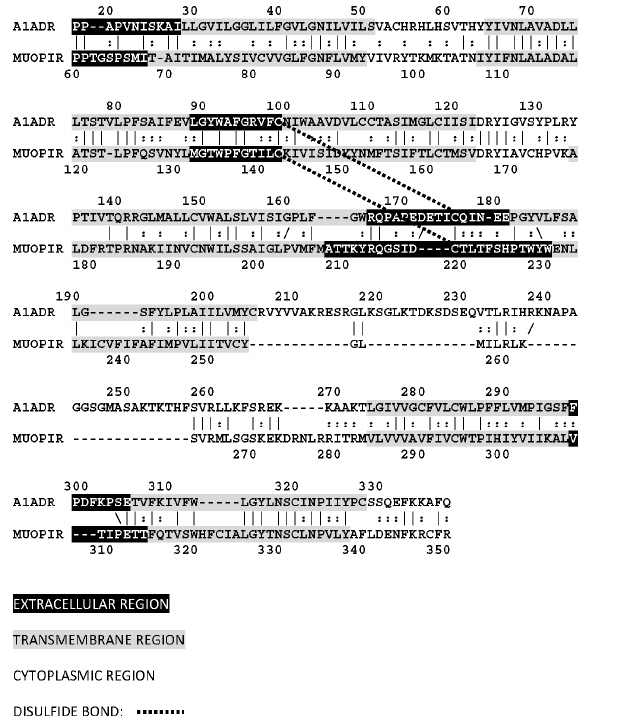
Figure 1. LALIGN (Available online: www.expasy.org) similarity comparison of the human α A1 adrenergic receptor (A1ADR) with the human mu opioid receptor (muOPR) displaying sequence similarities that exist primarily in the first extracellular loop (A1ADR 90–100) and second extracellular loop (A1ADR 165–582) regions (displayed in white lettering on black background), and in the flanking transmembrane regions. Bars represent amino acid identities as do back- or forward slashes; double dots represent similar amino acids. The dashed lines indicate disulfide bonds between cysteine residues. Notably, the third extracellular loop exhibits no significant similarity (A1ADR 297–306), nor do most of the cytoplasmic regions of the two receptors. Having identified similar regions shared by opioid and adrenergic receptors, we had five of the corresponding muOPR sequences synthesized as peptides as well as peptides from corresponding extracellular loops from other G-protein coupled receptors (Table 1). These peptides were then tested for binding to morphine, met-enkephalin, naloxone and various neurotransmitters and their agonists and antagonists to determine whether any of them might represent ligand binding regions appropriate for adrenergic enhancement of opioid receptor function. Binding was determined by UV